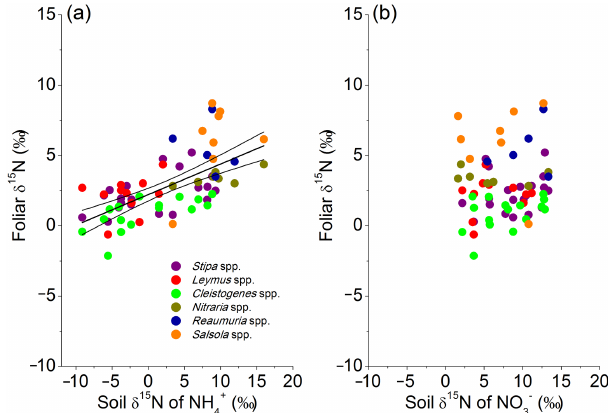
Figure 7. Relationship between the δ 15 N of foliage and δ 15 N of soil . Data on foliar δ 15 N ( Stipa spp., Leymus spp., Cleis- NH + and NO − 4 3 togenes spp., Reaumuria spp., and Salsola spp.) were from the pre- vious study of Wang et al. (2014). Almost all dominant plants were found in the area with MAP more than 100mm (semiarid zone). Data are the site-averaged values. The significant ( P< 0 . 05) trend is shown with a regression line (thick) and 95% confidence intervals